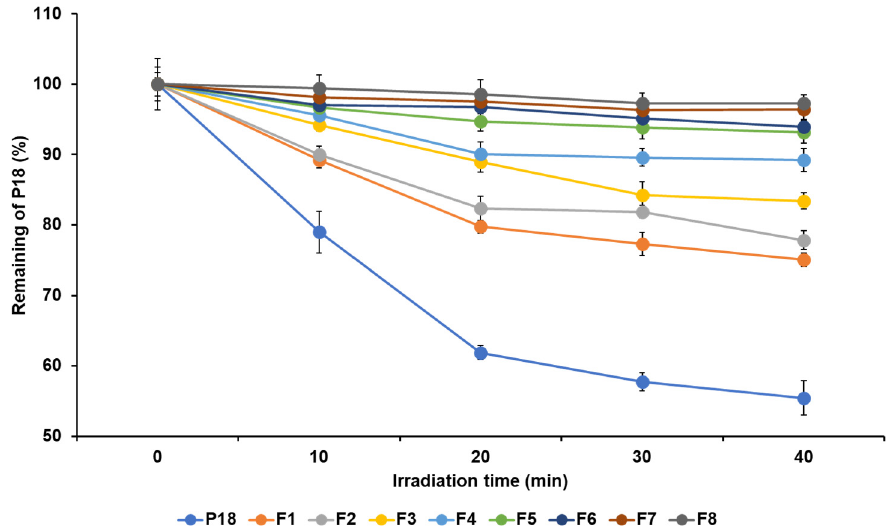
Figure 7. Photostability test based on percentage of nondegraded P18 in pure P18 solution and P18-loaded SLNs before and after irradiation of 2 J/cm 2 with LED, for time intervals of 0, 10, 20, 30, and 40 min. Results are expressed as means ± standard deviations of three independent experiments ( n = 3).